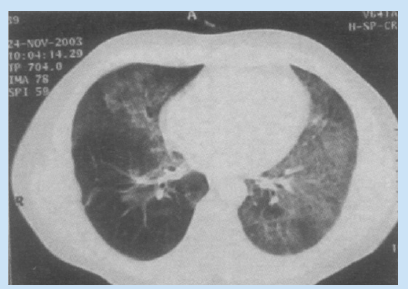
Fig. 1. Widespread, bilateral areas of ground glass opacities with inter- and intralobular septal thick- ening leading to a ‘crazy paving’ pattern.